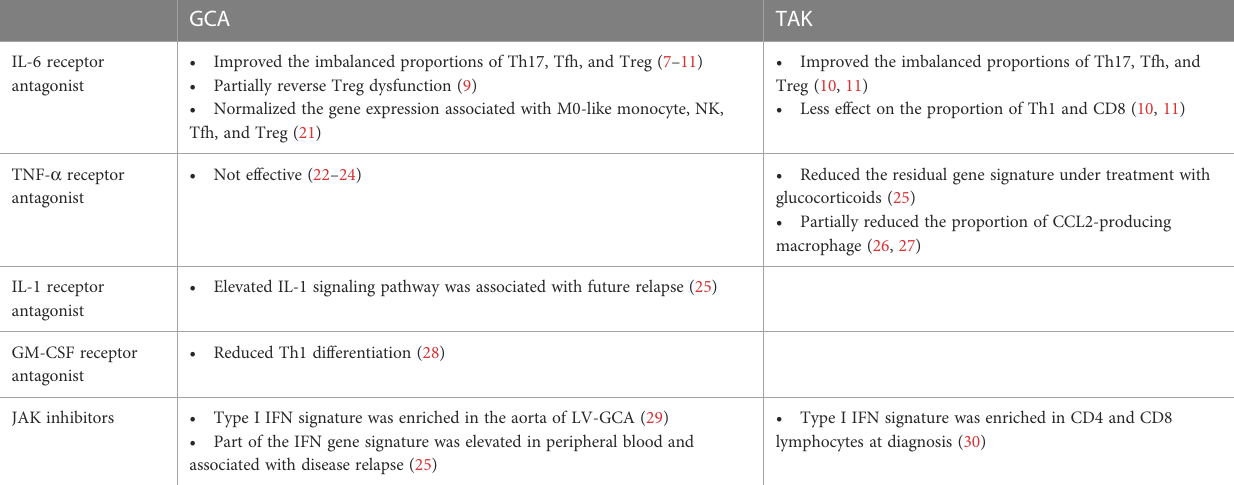
TABLE 1 Molecular pro fi les in patients with large vessel vasculitis associated with treatments.